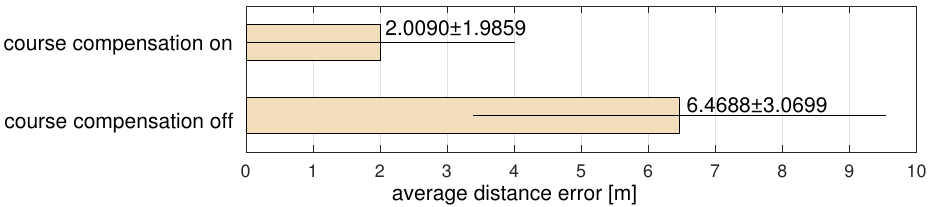
Figure 18. The distance deviation from the reference trajectory. The mean and standard deviation of the distance deviation with and without heading compensation, for both control modes.